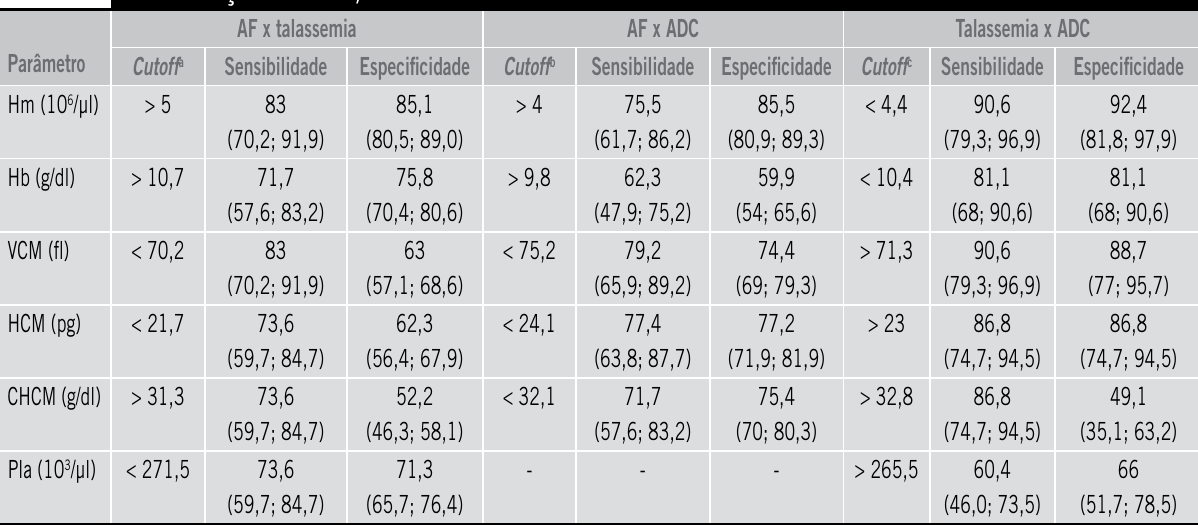
Sensibilidade, especificidade e pontos de corte ( cutoffs ) de parâmetros hematológicos na Tabela diferenciação entre AF, ADC e talassemia